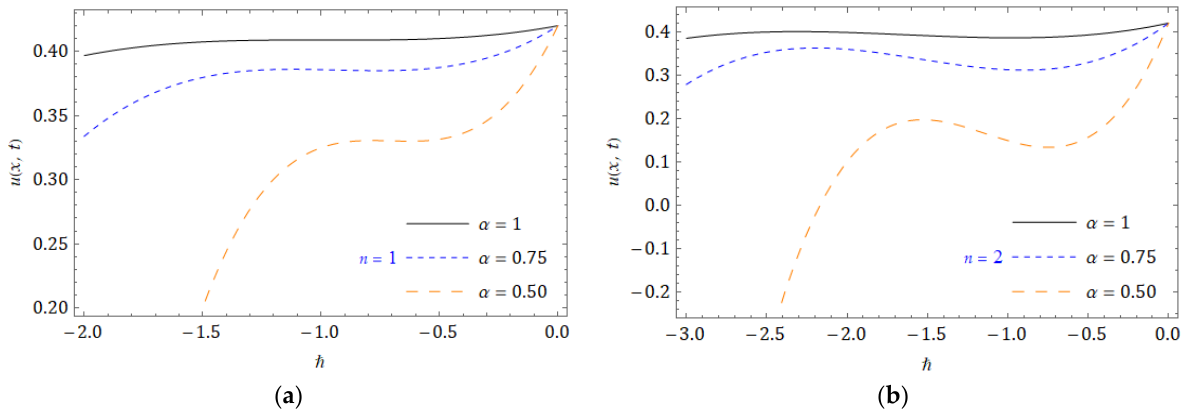
Figure 4. ℏ -curves for Case I at 𝑥 = 1, 𝑡 = 0.01, ℏ = −1, 𝛽 = 1, 𝑐 = −1, 𝜅 1 = 1 and 𝜌 = 0.001 for (𝑎) 𝑛 = 1 and (𝑏) 𝑛 = 2 .